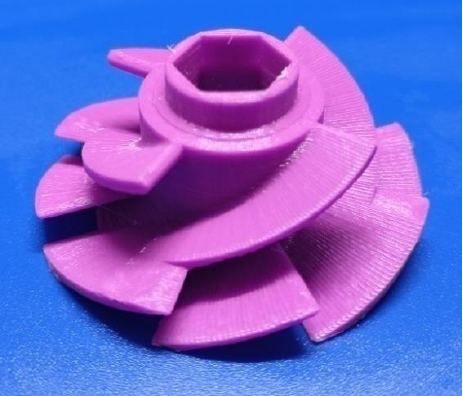
Figure 16. Impeller prototype of the new hybrid labyrinth pump. Source: authors’ development.